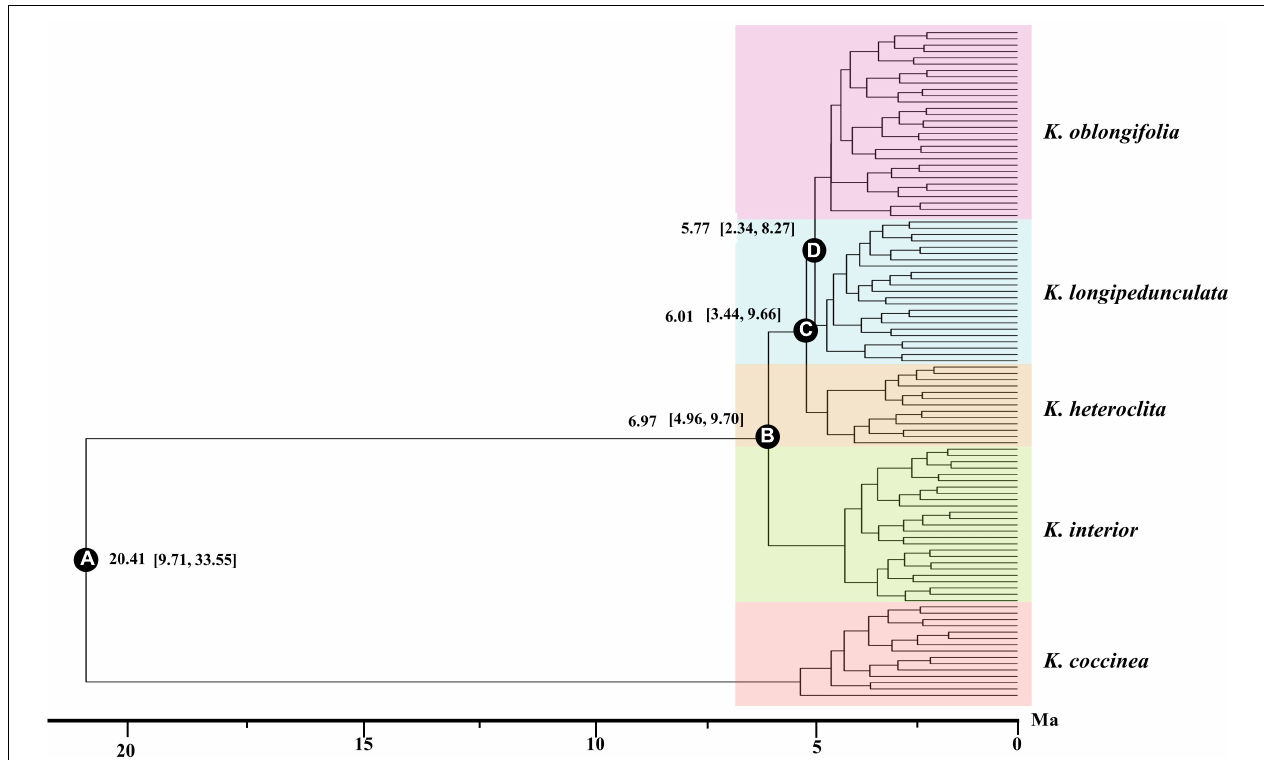
FIGURE 4 | BEAST chronogram of K. interior and its related species inferred from the RAD-seq data. The values in brackets represent the 95% highest posterior density intervals of node ages. The letters in the circles correspond to some selected major nodes. The bar below is the time from now, and the unit is Ma.